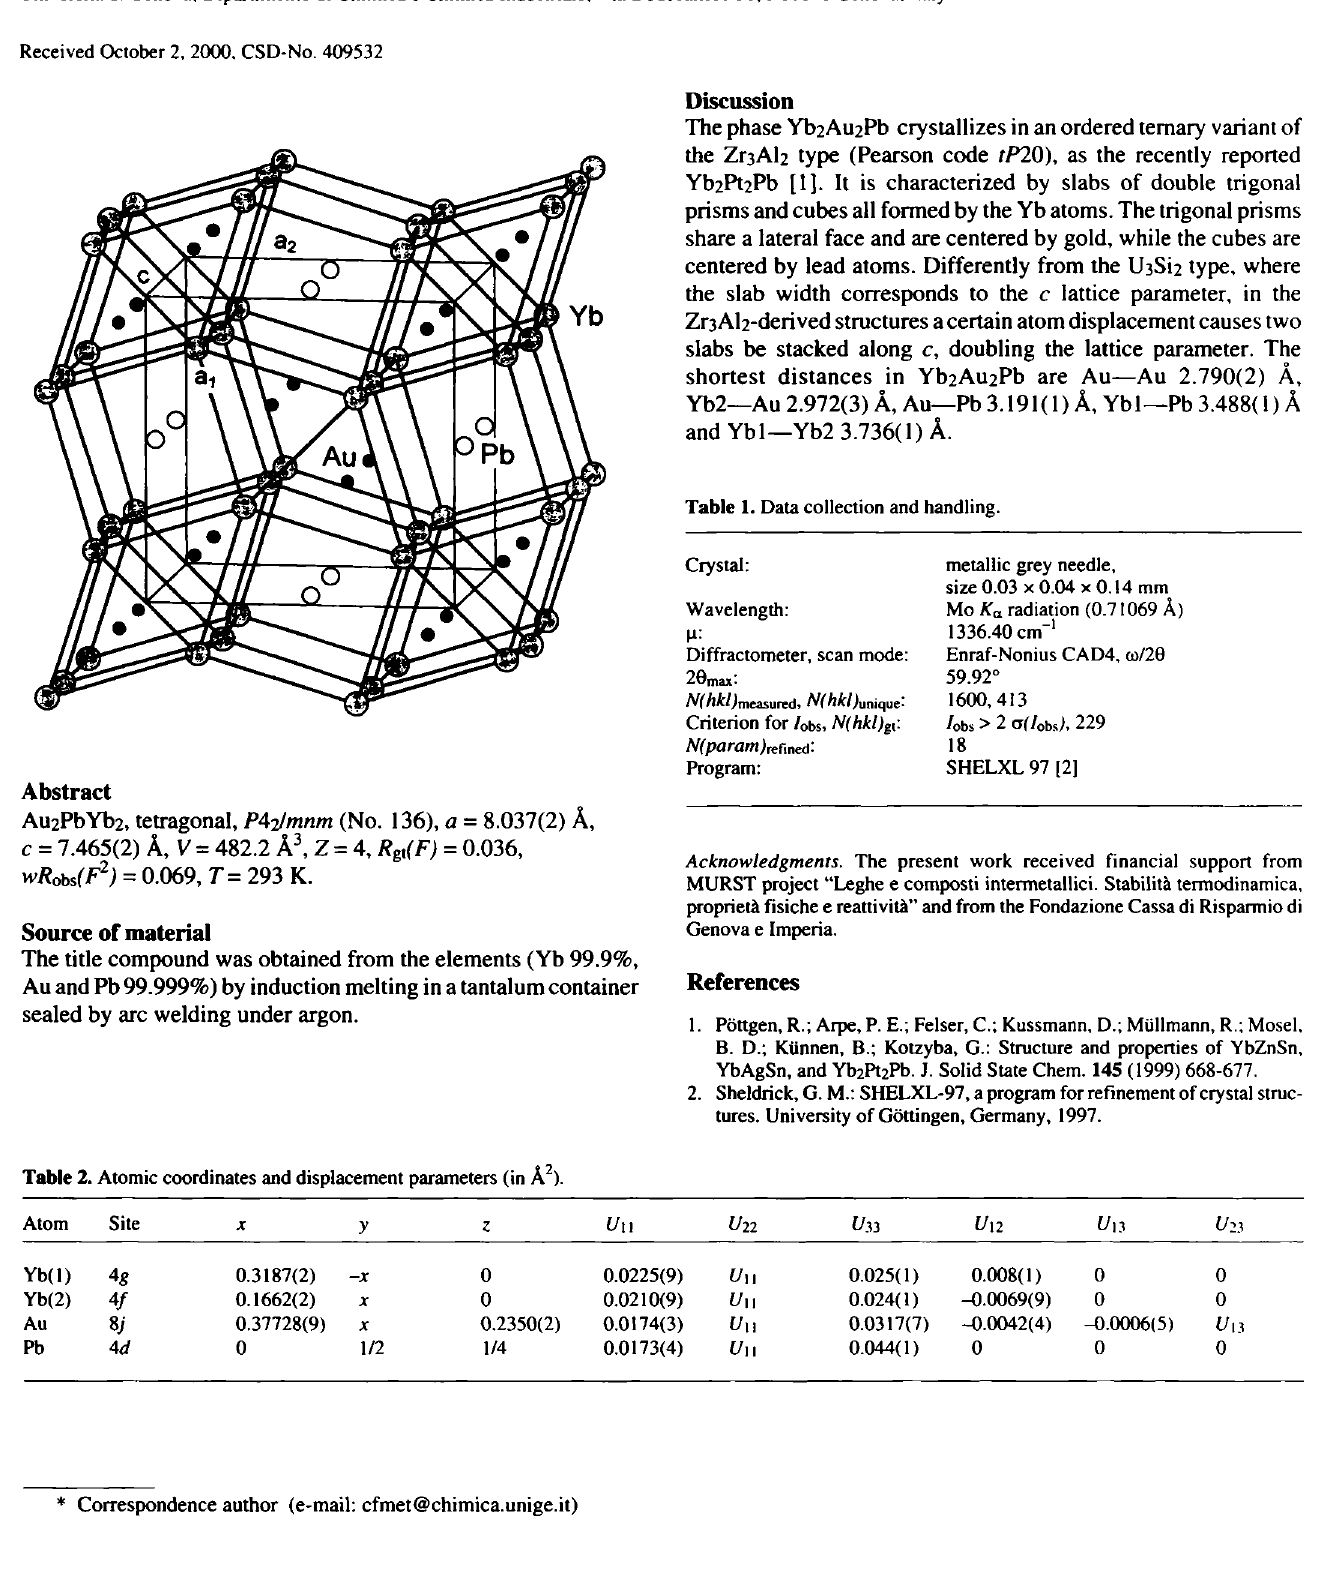
Table 2. Atomic coordinates and displacement parameters (in Ä 2